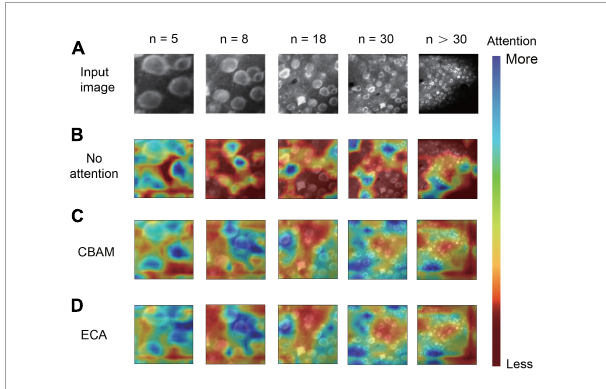
FIGURE4 Visualization of attention mechanisms on different numbers of neurons. (A) The input two-photon images with different numbers of neurons. (B–D) The difference in image feature focusing between no attention module (B) , convolutional block attention module (CBAM) (C) , and efficient channel attention (ECA) (D) . We use Grad-CAM for the visualization of attention effects (n is the number of neurons in each